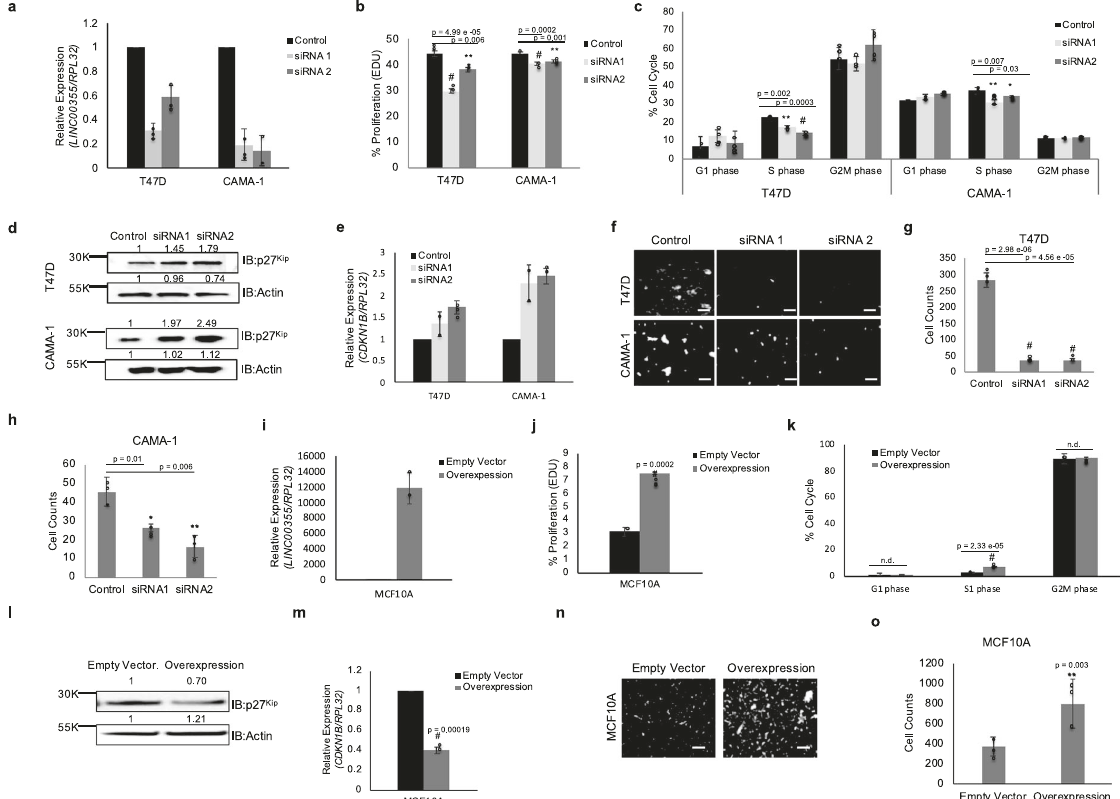
Fig. 3 LINC00355 induces a proliferative and aggressive phenotype in primary breast cancer cells . a Transient knockdown of LINC00355 in T47D and CAMA-1 cell lines. b Decreased LINC00355 expression decreased proliferation measured by EdU incorporation and c decrease in S phase. Decreased LINC00355 expression increased d p27 Kip protein and e CDKN1B mRNA levels. Fold change normalized to control. f – h Knockdown expression of LINC00355 decreased cellular invasion. i MCF10A cell line with LINC00355 overexpression and empty vector. j LINC00355 overexpression increased proliferation measured by EdU incorporation and k increase in S phase. LINC00355 overexpression decreased l p27 Kip protein and m CDKN1B mRNA levels. Fold change normalized to empty vector. n and o LINC00355 overexpression increased cellular invasion. * p value < 0.05, ** p value < 0.005, # p value < 0.0005, no difference (n.d.). All data are presented as mean values ± s.d, analyzed by two-tailed paired t test, and repeated more than two times. Bar = 25 µM, Dapi stained nuclei are shown in white. Source data are provided as a Source Data